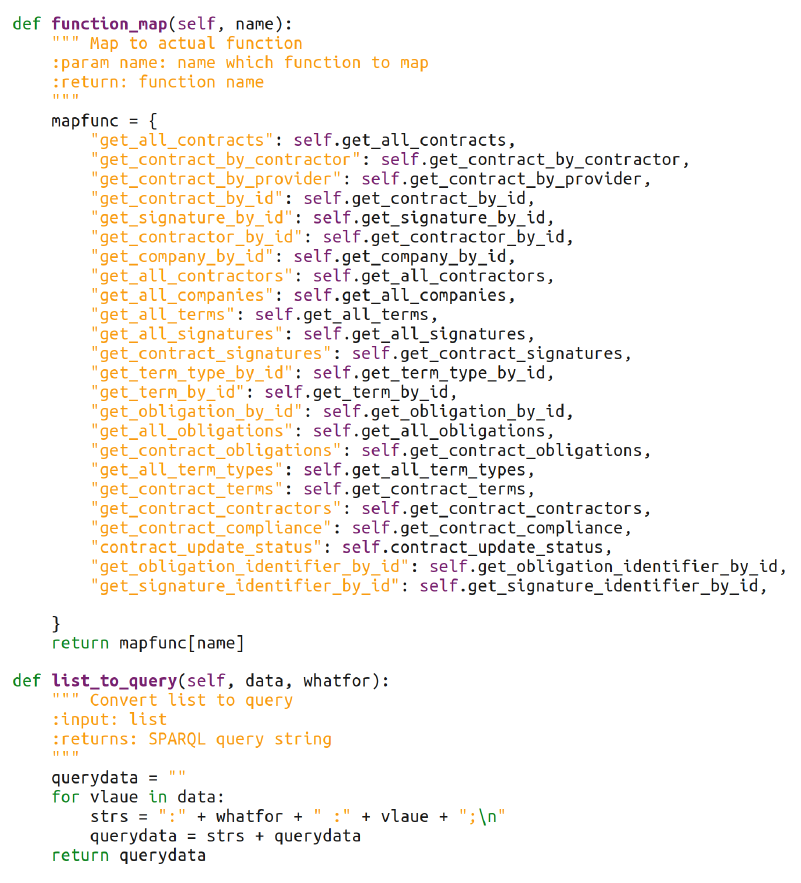
Figure 9. A snippet of code from the helper module.